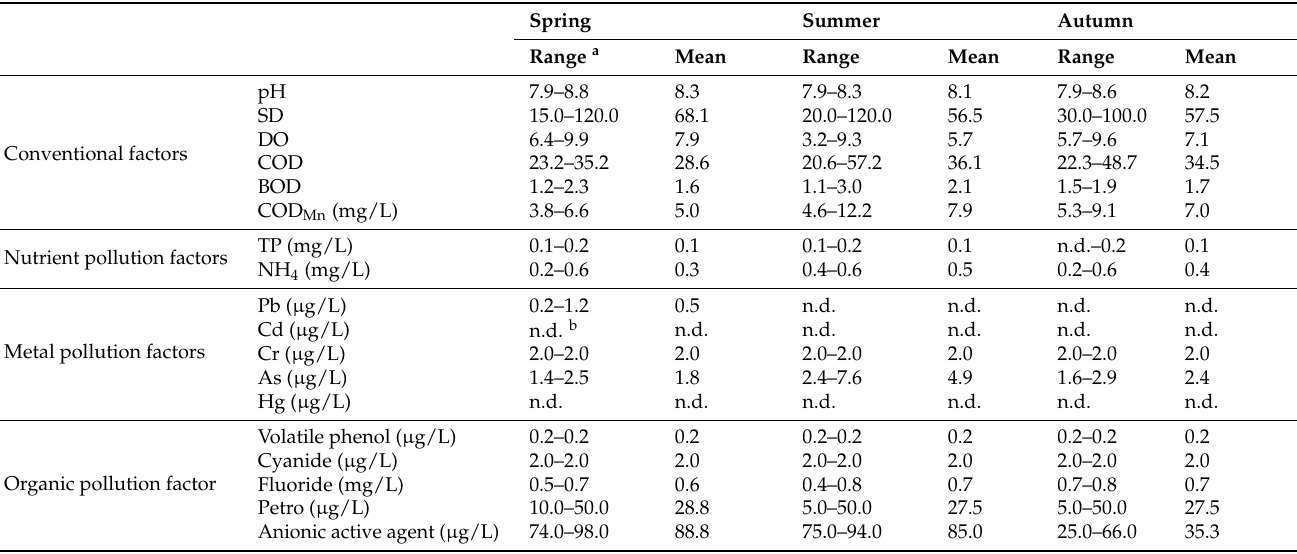
Table 7. Range and mean concentrations of the contaminants detected in the water in the spring, summer, and autumn.